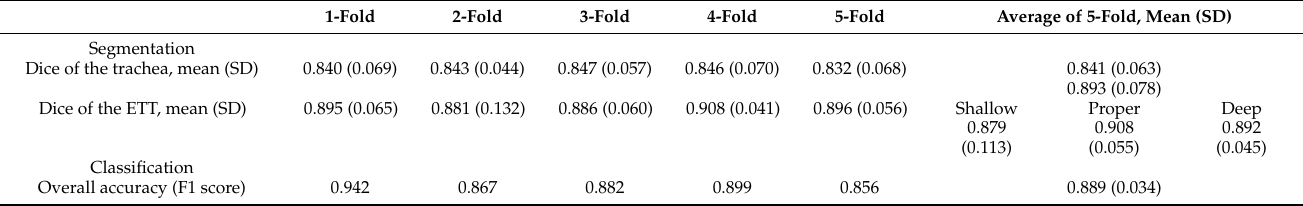
Table 2. Outcomes of five-fold validation for automatic segmentation of the trachea and the ETT and classification of four labels according to the ETT